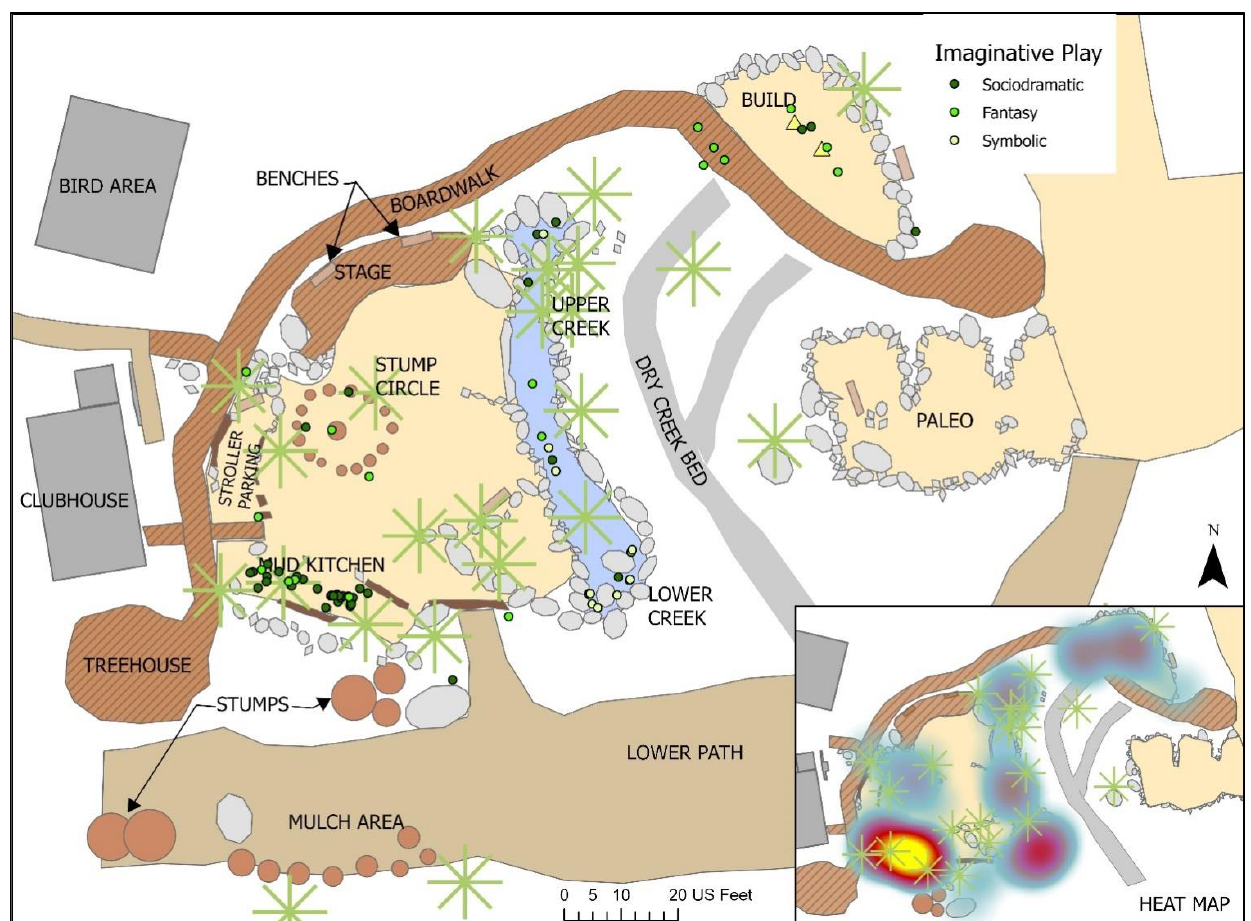
Figure 16. Behavior map of all Imaginative Play activities.